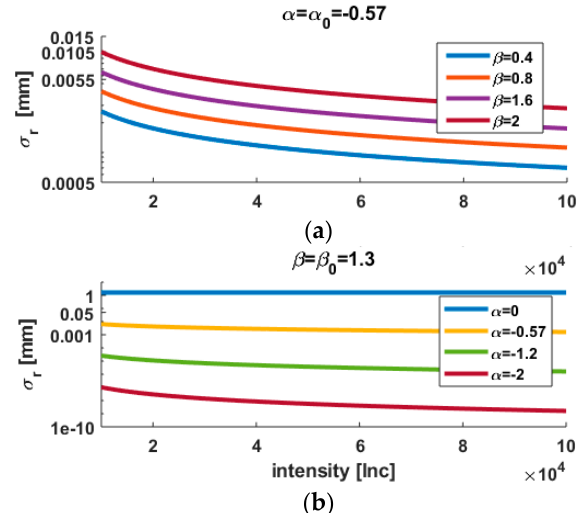
Figure 1. Variations of σ r (log plot) versus intensity with the intensity-based model ( a ) for different the scaling factors β and ( b ) different power factors α r .